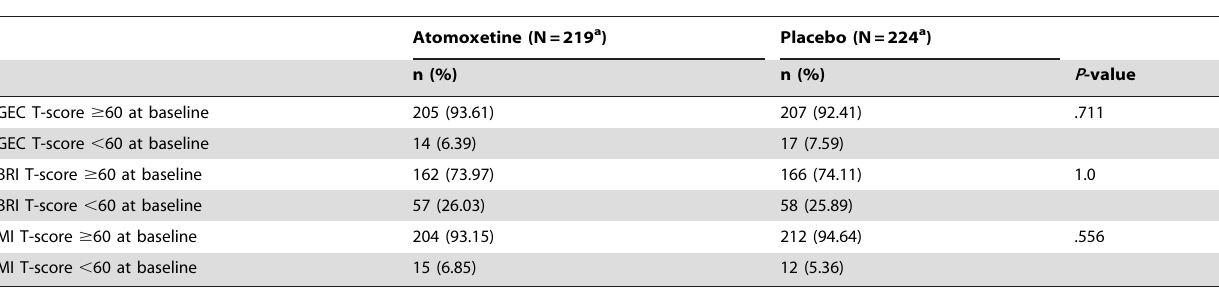
Table 2. BRIEF-A Baseline Subscale